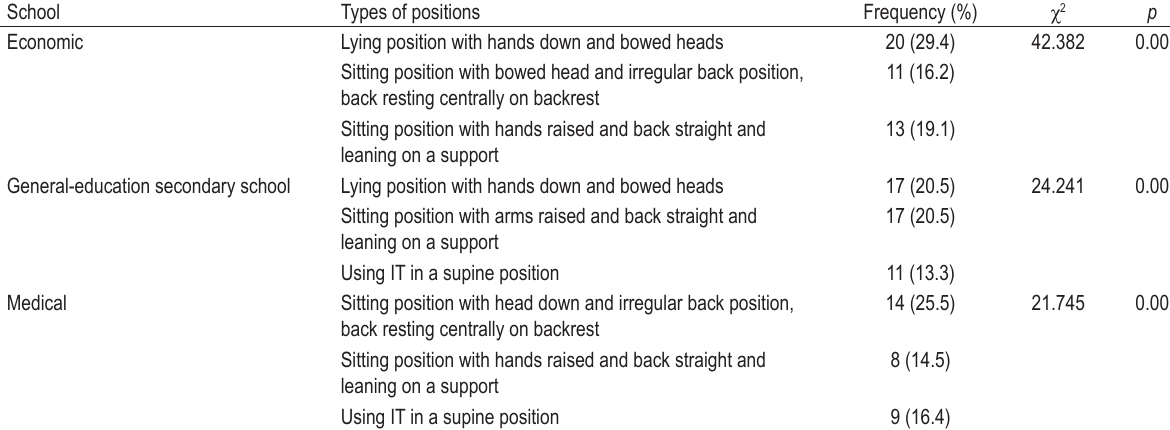
Medical Sitting position with head down and irregular back position, Sitting position with hands raised and back straight and